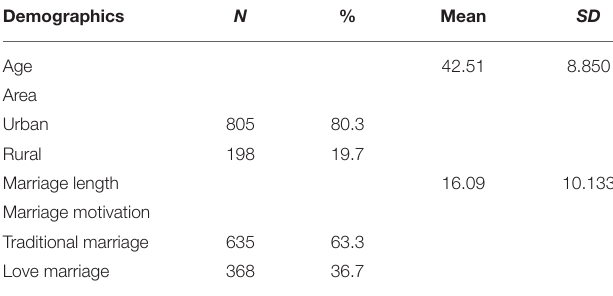
TABLE 1 | Participants’ demographic characteristics ( N =